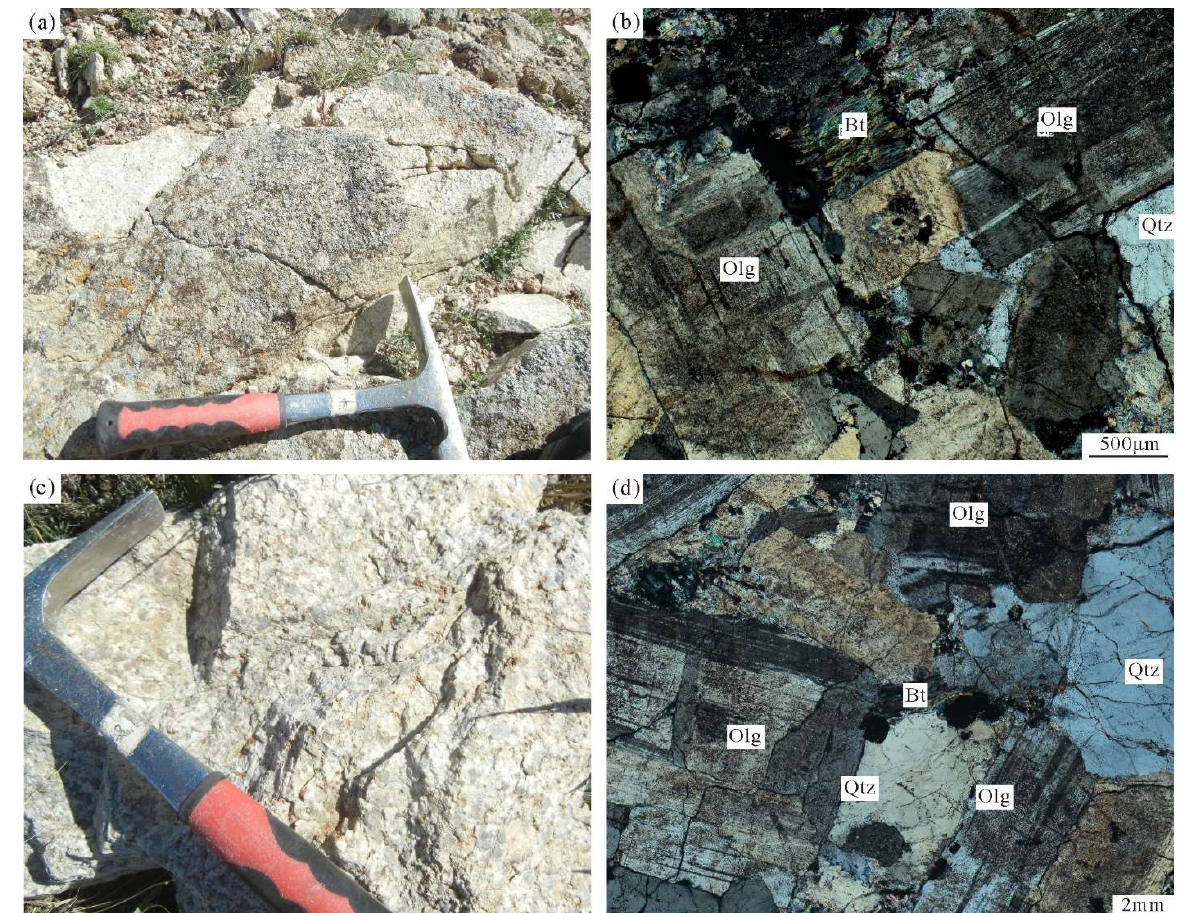
Figure 3. Field occurrences ( a , c ) and photomicrographs ( b , d ) of the Gaolihan trondhjemite. ( a ) Field occurrence of the fine-medium-grained trondhjemite. ( b ) Characteristic fine-medium-grained subhedral granular texture of the trondhjemite. ( c ) Field occurrence of the coarse-grained trondhjemite. ( d ) Photomicrograph of the trondhjemite. Olg—oligoclase; Qtz—quartz; Bt—biotite